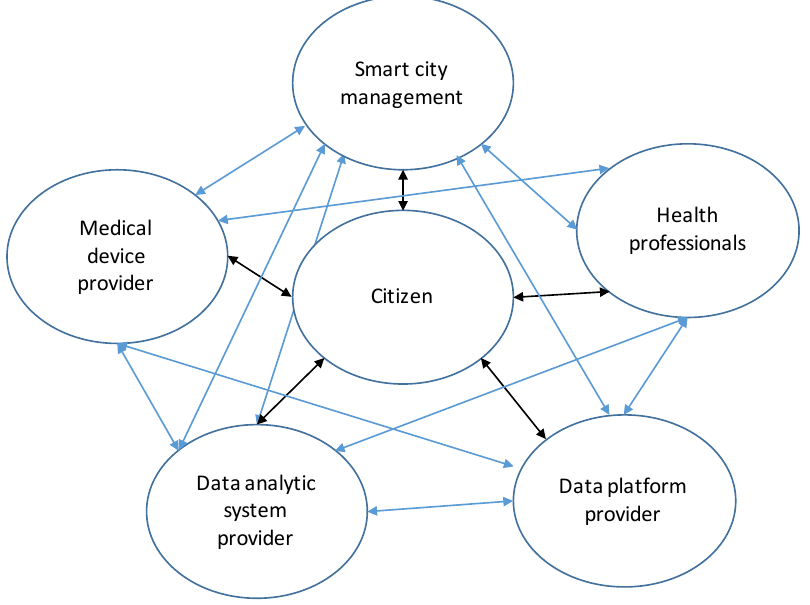
Fig. 1. Smart city service delivery